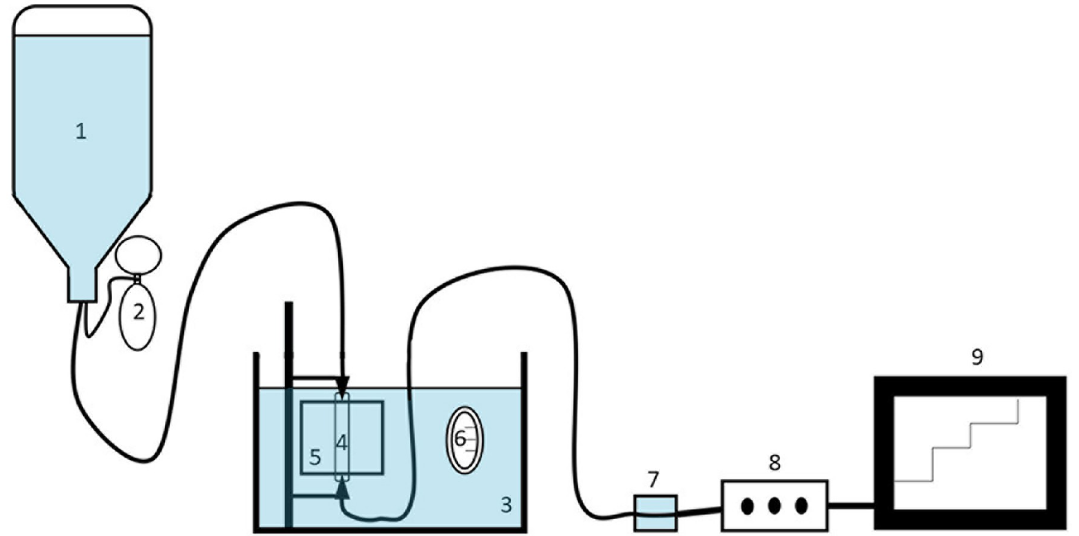
Fig 2. Schematic overview of the custom-made pressurisation system for the inflation-extension test under ultrasound monitoring. 1: pressure reservoir containing 0.9% NaCl at 37˚C; 2: inflation balloon to adjust pressure; 3: water bath containing 0.9% NaCl at 37˚C; 4: pressurised arterial sample; 5: silicone window in the water tank, through which ultrasound images were obtained; 6: bath thermometer; 7: fluid filled pressure transducer; 8: acquisition station; 9: visualisation of actual pressure in the arterial segment on